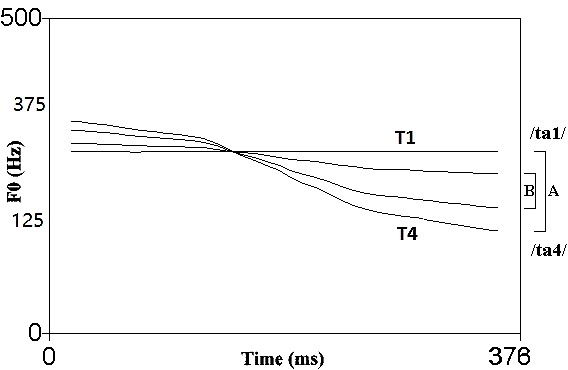
Pitch contours of the contracted T1–T4 [B] contrast created from T1–T4 [A] and adopted in the current study. The contrast salience was reduced through this manipulation. (Source: Liu and Kager, 2017a).